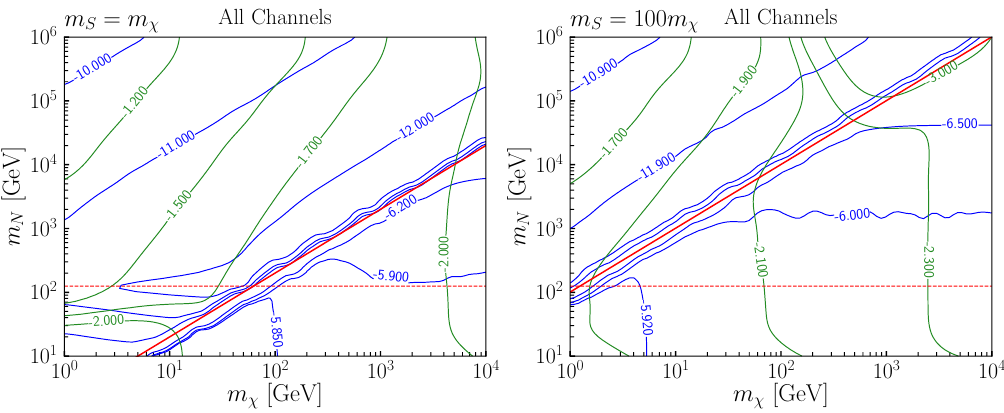
Figure 8 . Same as (cid:12)gure 7, but considering decays, s-channels and t-channels for the establishment of the relic density of (cid:31) . Solid (dashed) red lines are for m N = m S + m (cid:31) ( m N = m h = 125